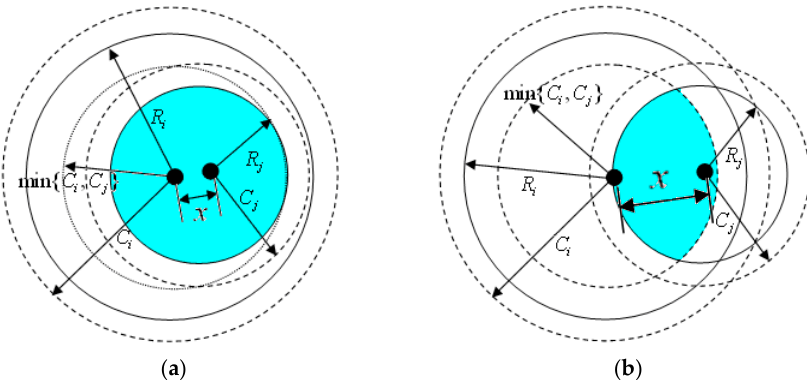
Figure 5. The maximum distance between point X and the neighbor node. ( a ) x < min{ C i , C j }; ( b ) min{ C i , C j } − R j ≤ x ≤ R j